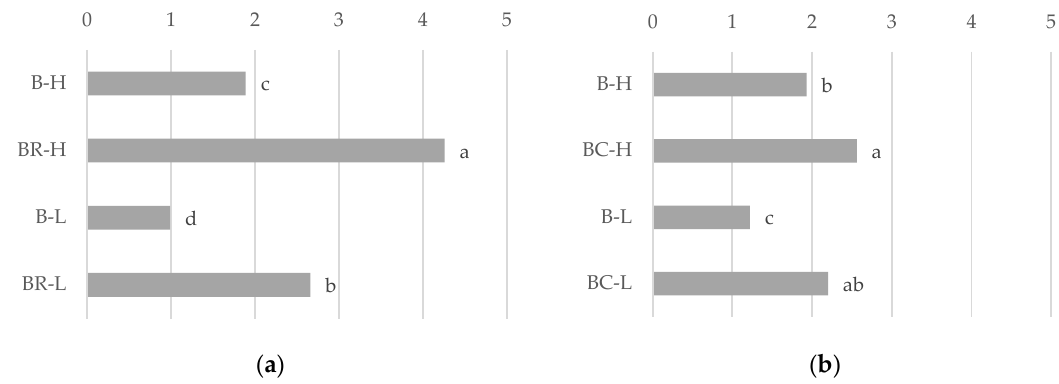
Figure 1. Post ‐ harvest residue biomass, g pot –1 : ( a ) Experiment I, with Italian ryegrass as CC; ( b ) Experiment II, with red clover as CC. Different letters next to the bars indicate significant differences at p < 0.05.